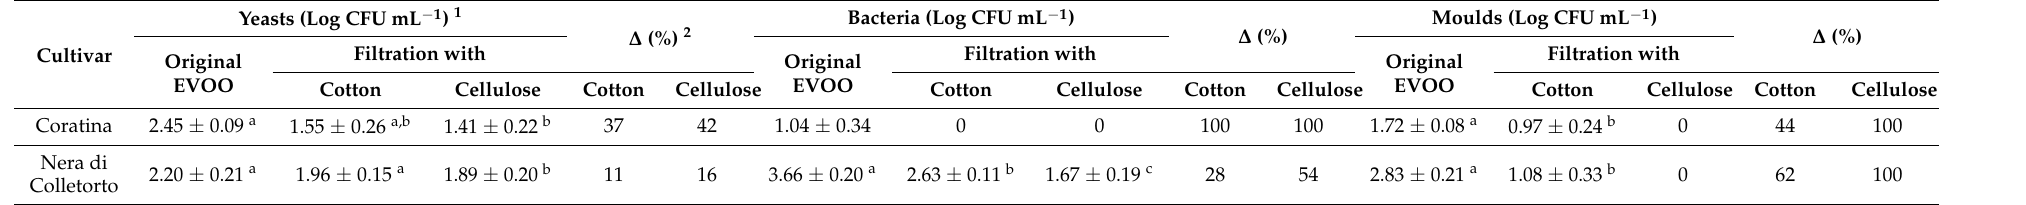
Table 3. Microbiological analysis of freshly produced extra virgin olive oil from two monocultivars subjected to